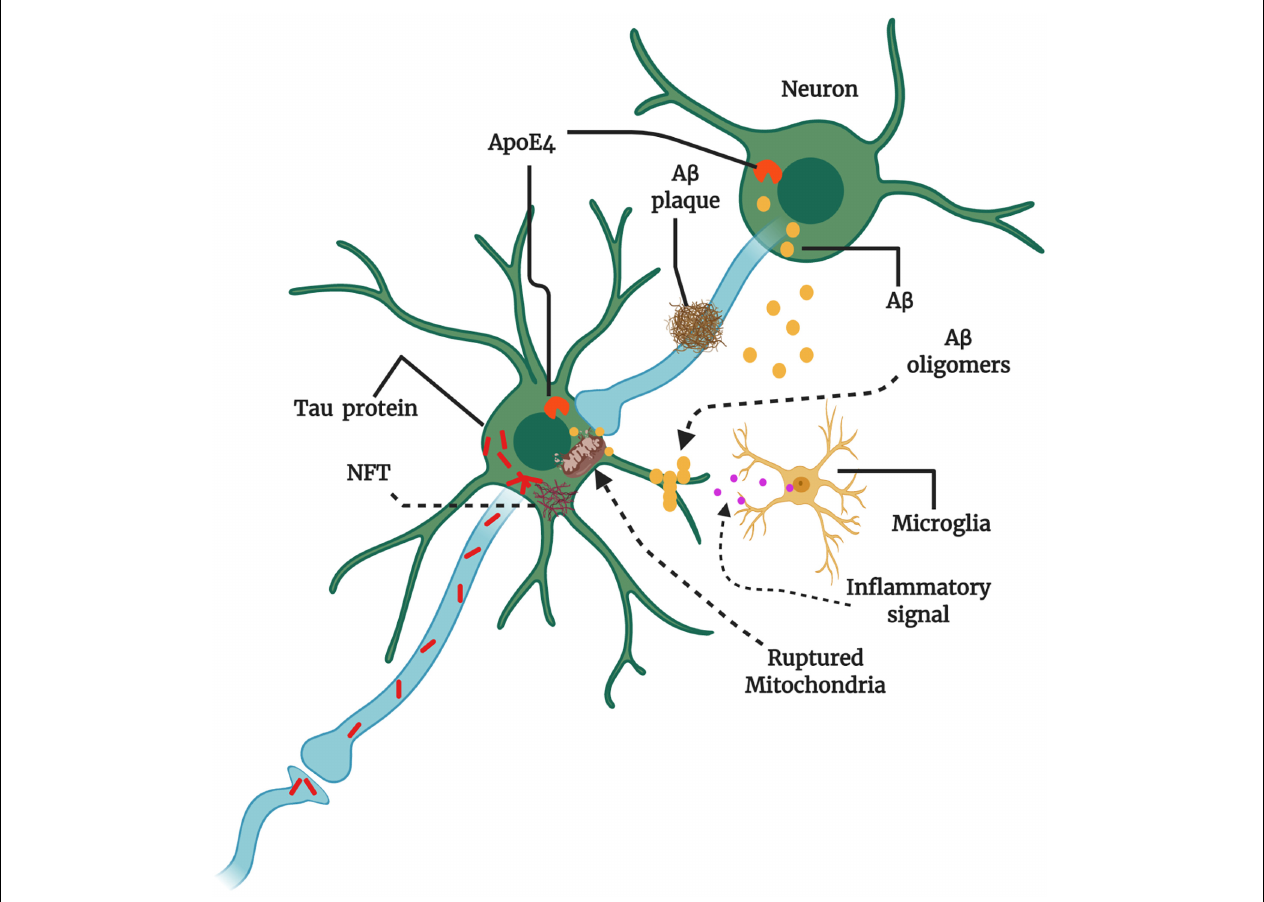
FIGURE 2 | Key players and therapeutic targets in AD pathogenesis. The production of amyloid-beta (A β ) instead of clearance can cause A β oligomerization. A β oligomers transmit through synapses, and A β plaque formation may hinder synaptic plasticity and transmission. The abundant intracellular A β can surround mitochondria and impair mitochondrial function, resulting in the release of reactive oxygen species (ROS), the activation of microglia, and the production of inflammatory signals. Microglial activation can be both beneficial and detrimental depending on the engaged signaling cascade. The protein tau also may aggregate and form large intraneuronal pathogenic aggregates known as neurofibrillary tangles (NFTs). Therapies might target amyloid precursor protein (APP) in the neuronal membrane to reduce A β production, increase A β clearance from synapses, and reduce A β oligomer formation. Apolipoprotein E4 (ApoE4) and tau can also promote A β production. Misfolded tau within neurons aggregate into NFTs, and misfolded tau can be transmitted through the synapse to affect other neurons. Therapies could be designed to reduce tau aggregation or misfolding. Multiple factors are involved at various stages of AD progression, damaging neuronal circuits and causing neuronal loss and neurological decline (Conceptualized from 58, Created with